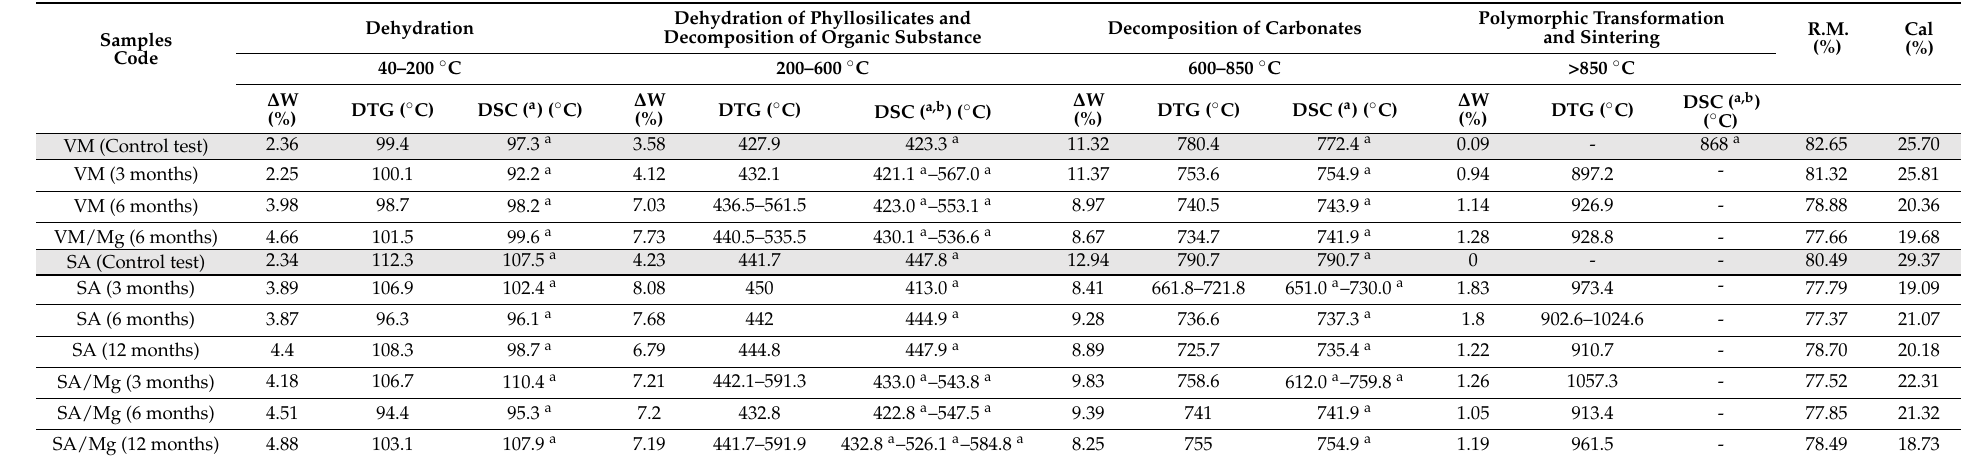
Table 6. Simultaneous Thermal Analysis